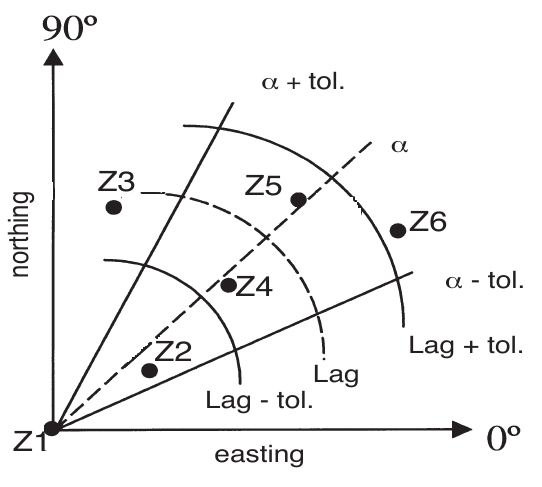
F IG . 2. – Computation of the experimental variogram for distance class Lag and direction α . Starting from the sampling point Z1 and specifying α ±tol, sampling points Z3, Z4 and Z5 would be inclu- ded in the computation of the omnidirectional variogram. For a directional variogram specifying a direction α and an angle tole- rance ±tol, only the sampling points Z4 and Z5 would be taken into account. The computation of the experimental variogram proceeds in this manner using eq. (1) of the Appendix, starting from each sampling point at a